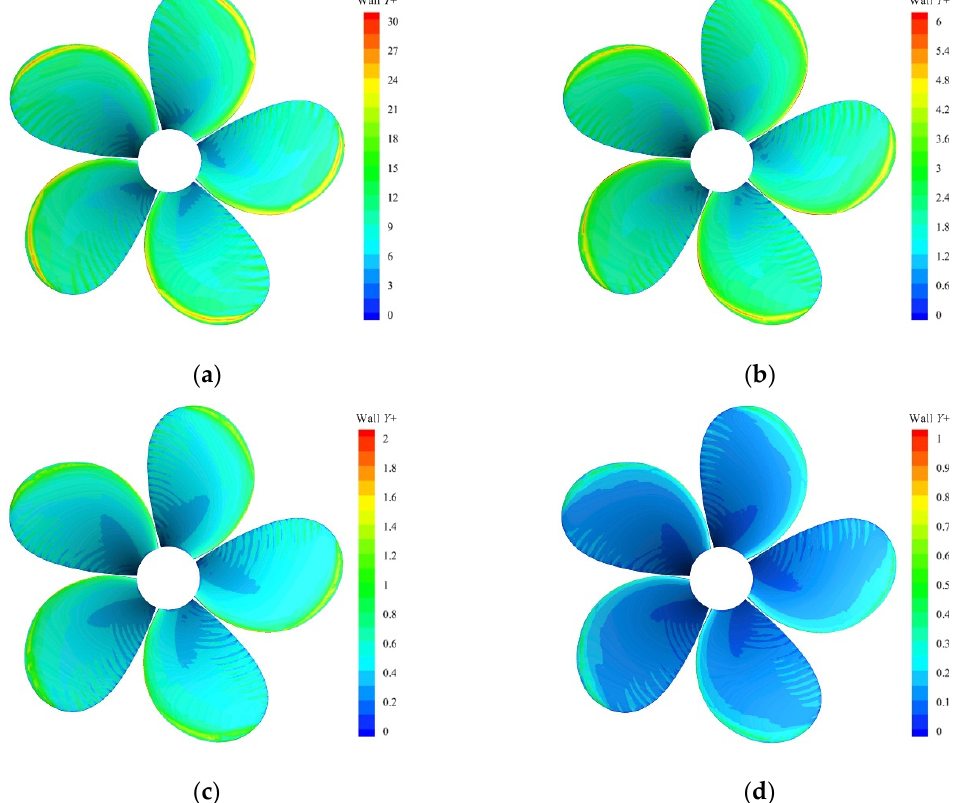
Figure 5. Contours of wall Y + on blade surface at J = 0.7: ( a ) five layers; ( b ) 10 layers; ( c ) 15 layers; and ( d ) 20 layers.